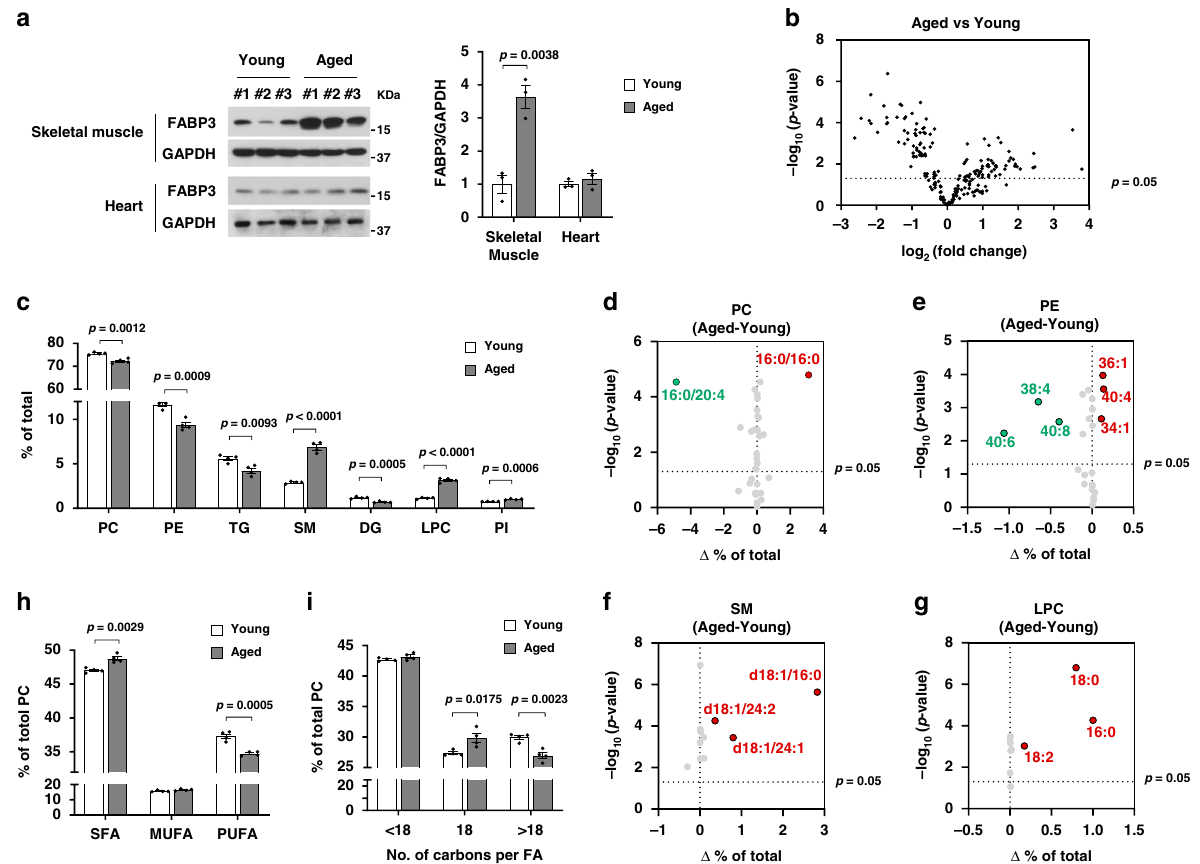
Fig. 1 Lipidomic signature of aged muscle. a Immunoblots (top) and quanti fi cation (bottom) of the indicated proteins in skeletal muscle and heart isolated from young and aged mice ( n = 3 mice per group). b Volcano plot of lipid species altered in aged vs. young muscle ( n = 4 mice per group). Lipid species were measured by LC-MS. The x -axis indicates the logarithmic (base 2) fold abundance changes of all identi fi ed lipid species and the y -axis indicates negative logarithmic (base 10) t -test p -value. The horizontal dotted line re fl ects the fi ltering criterion ( p -value = 0.05). c Proportion of major lipid classes in young and aged muscles. d – g Volcano plots of PC ( d ), PE ( e ), SM ( f ), and LPC ( g ) species altered in aged vs. young muscles. The x -axis indicates the percentage changes (aged-young) in lipid abundance and the y -axis indicates negative logarithmic (base 10) t -test p -values. The horizontal dotted line re fl ects the fi ltering criterion ( p -value = 0.05). Red and green indicate highly increased and decreased lipid species, respectively. h Proportion of saturated (SFA), monounsaturated (MUFA), or polyunsaturated (PUFA) PC acyl chains in young and aged muscles. i Proportion of <C18, C18, or >C18 PC acyl chains in young and aged muscles. Data are presented as means ± S.E.M. Two-tailed unpaired Student ’ s t -test was used. Source data are provided as a Source Data fi PC acyl chains increased in FABP3-overexpressing muscle, while polyunsaturated acyl chains decreased (Fig. 2g). Polyunsaturated 40:6, 40:7, and 44:10 PEs signi fi cantly decreased, but 36:2, 36:4, 36:3, and 34:2 PEs increased in FABP3-overexpressing muscle (Fig. 2d and Supplementary Fig. 2e). When the PE species containing the same number of double bonds were combined, PEs with more double bonds decreased in FABP3-overexpressing muscle, whereas PEs containing fewer double bonds increased, indicating that PE acyl chains were shifted toward saturation in FABP3-overexpressing muscle (Supplementary Fig. 2f). This pattern of phospholipid saturation in FABP3-overexpressing muscle was similar in aged muscle. SM and LPC species increased in FABP3-overexpressing muscle (Fig. 2e, f and Supplementary Fig. 2g, h). Regarding PC acyl chain length, C18 acyl chains increased in FABP3-overexpressing muscle, while >C18 acyl chains decreased, similar to aged muscle (Fig. 2h). Finally, we analyzed the correlation of the up/down ratio of all identi fi ed lipid species between aged and FABP3-overexpressing muscles in comparison with young muscles (Fig. 2i). Surprisingly, a strong linear correlation was found in lipid composition between aged muscle and FABP3-overexpressing young muscle. Based